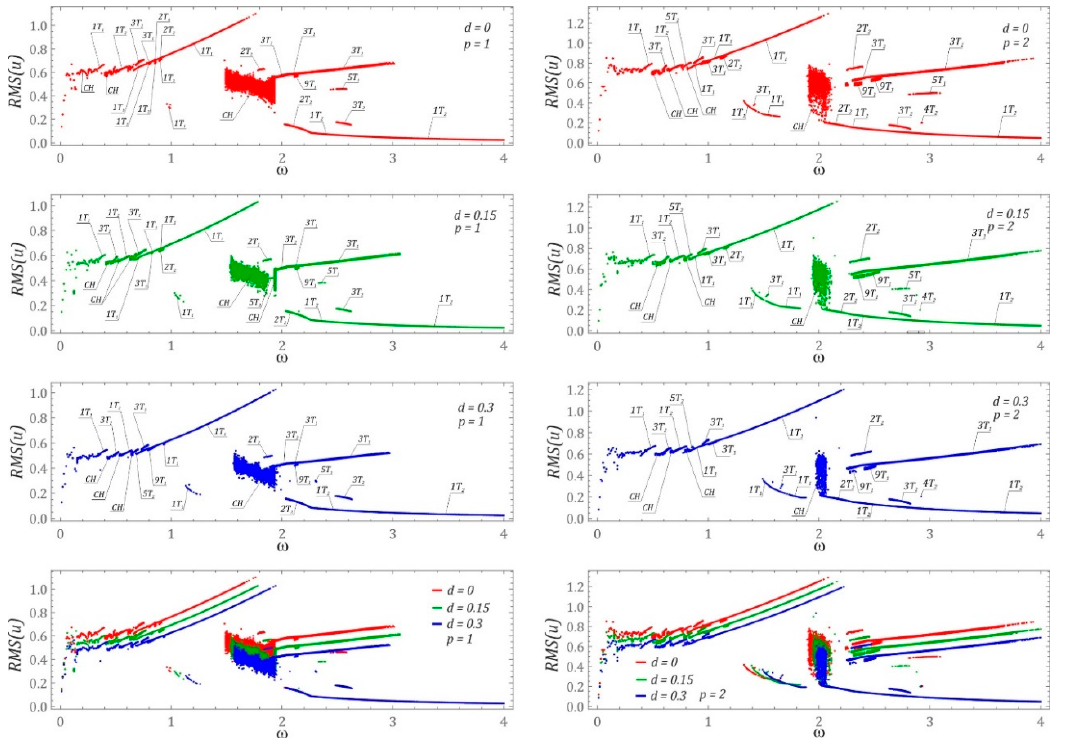
Figure 4. Bifurcation diagram: effect of parameters d and p on energy recovery efficiency with various initial conditions considered simultaneously for the given system parameters. The parameters are indicated in the figures. For better clarity, the solutions are marked by nT m ( n —the response period, m —the number of different solutions with the same response period). The bottom panels are the summery of the upper left and right parametric cases to show the tendencies of the system evolution with d parameter changes.